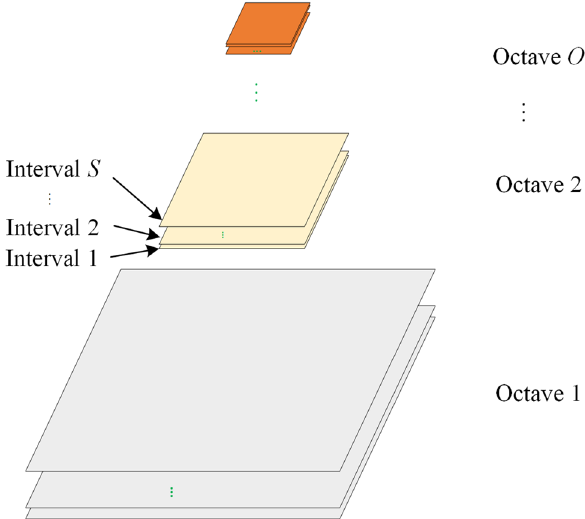
Figure 1. Octave Gaussian pyramid.